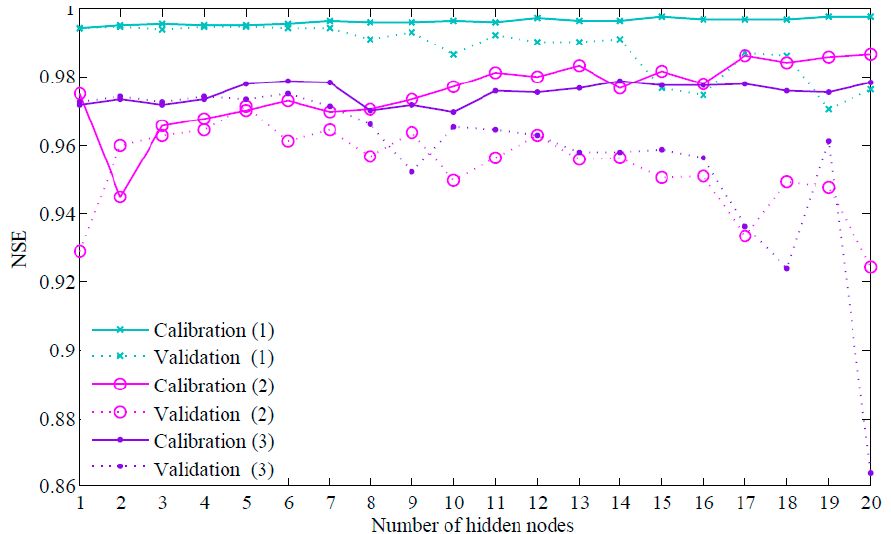
Figure 4. Performance of different hidden nodes of each ANN bias-correction model (ABCM). NSE, Nash and Sutcliffe efficiency coefficient.